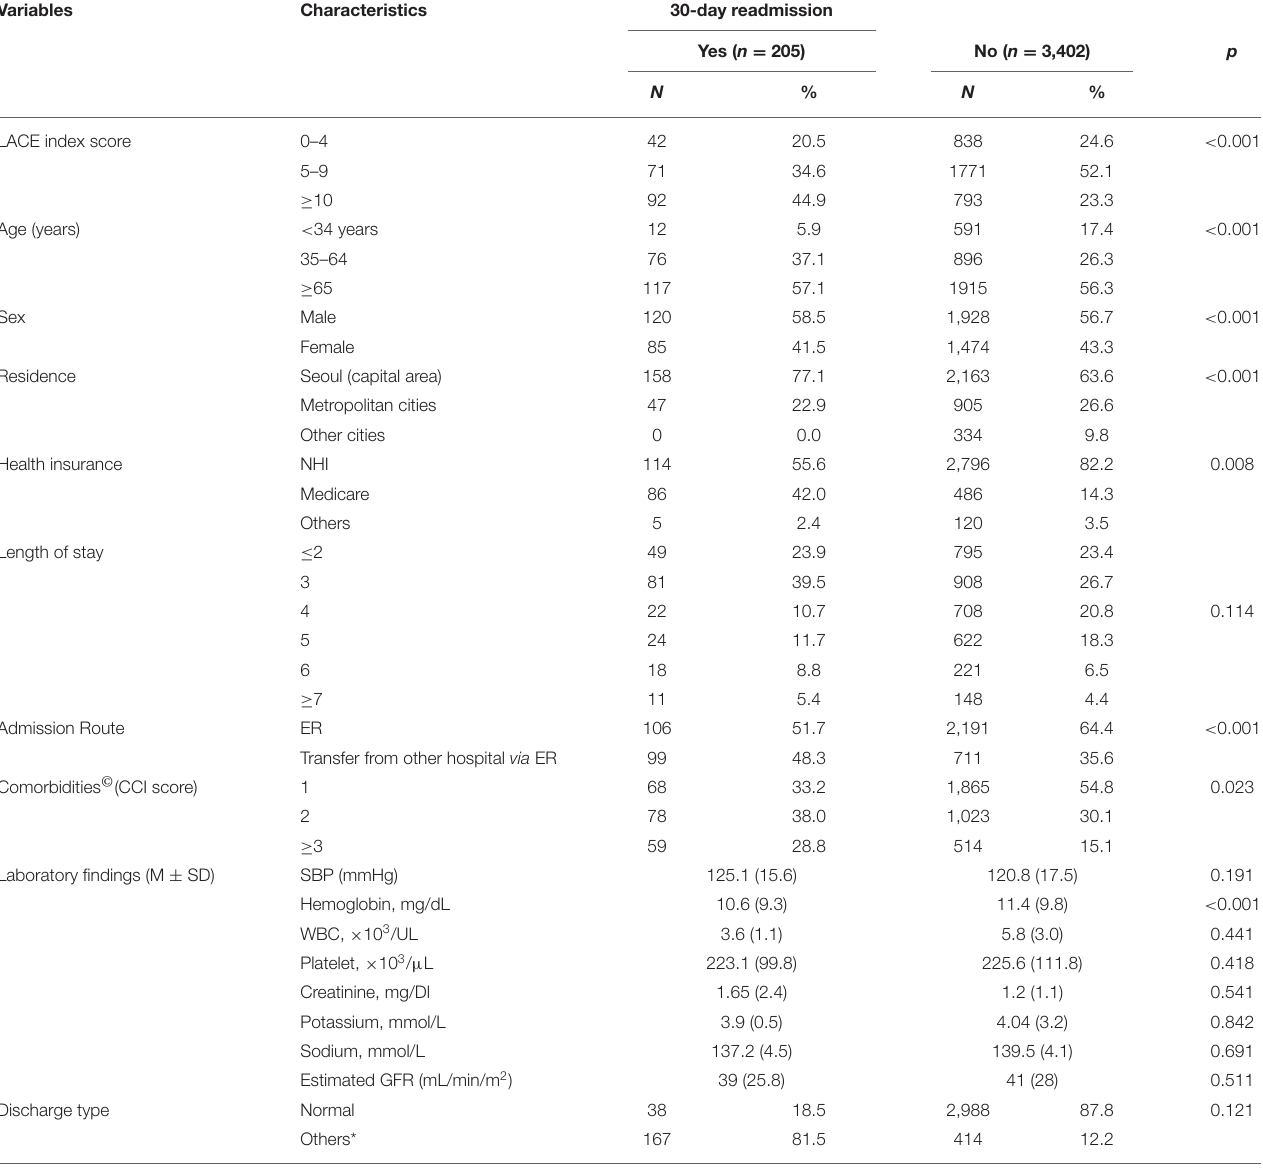
TABLE 1 | Baseline characteristics of 30-day readmission vs. no readmission patients admitted with AMI.